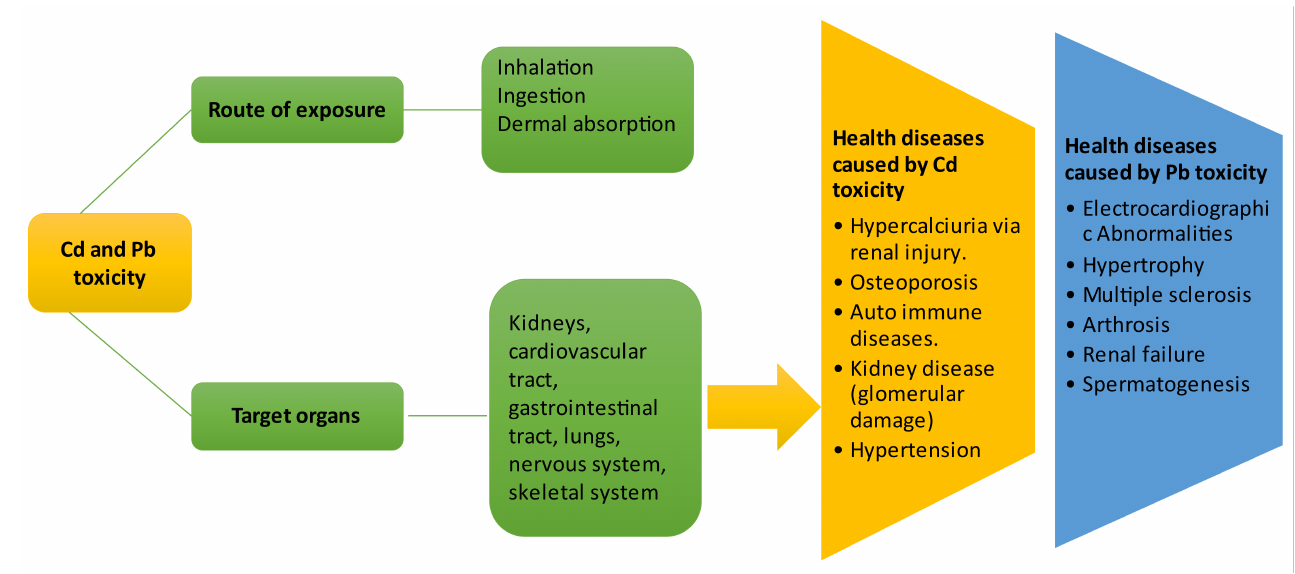
Figure 5. Pathways of lead and cadmium and their impact on human